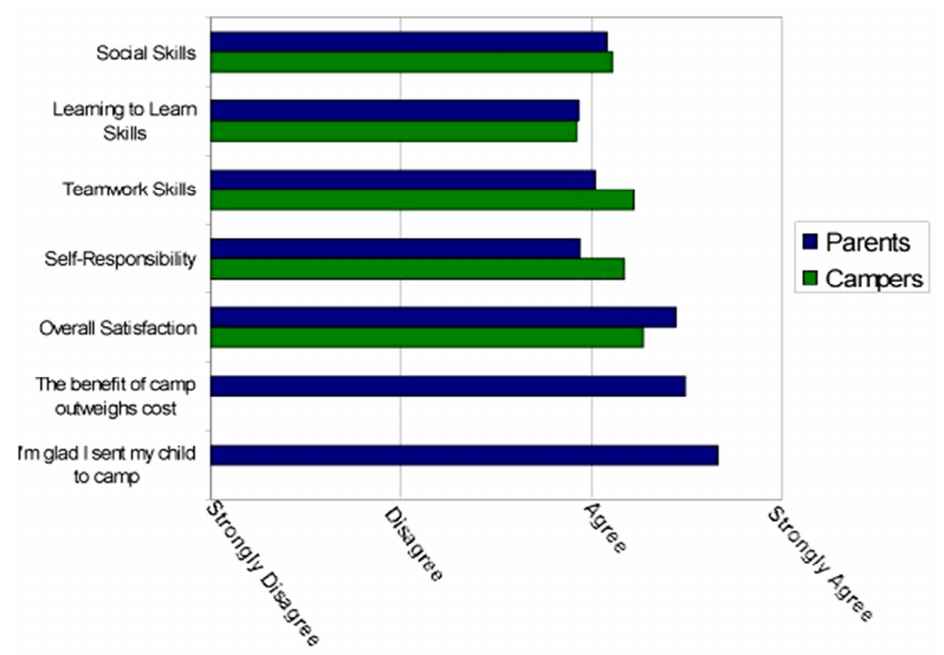
Summary of 2005 and 2006 camper and parent responses to perceived life skill development and